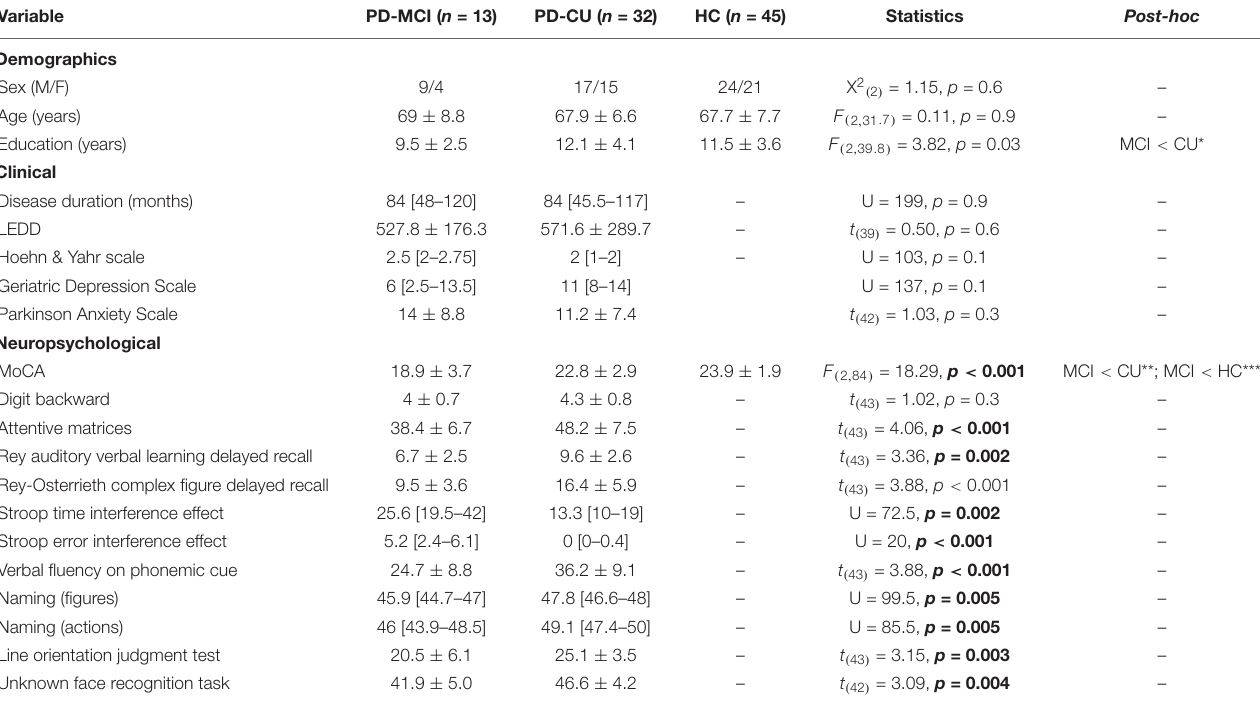
TABLE 2 | Demographic, clinical, and neuropsychological features of Parkinson’s disease (PD) patients and healthy controls (HC). Variable